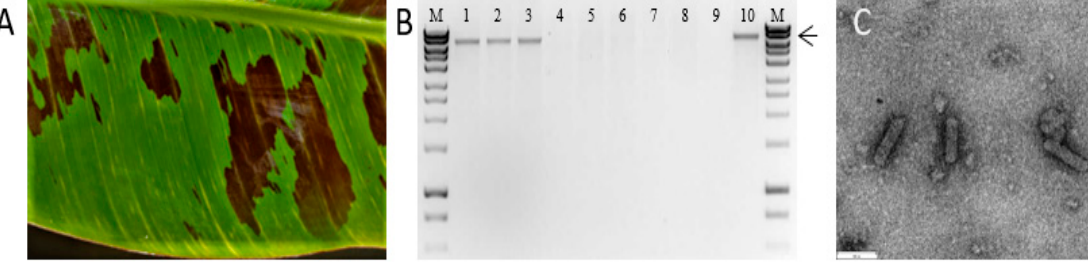
Figure 2. Inoculation of Cavendish (Williams-AAA) bananas with pOPT-EBX-BSCAV. ( A ) Typical chlorotic leaf streak symptoms of BSV infection at five weeks post-inoculation. ( B ) Rolling circle amplification analysis of TNA extracts prepared from inoculated and non-inoculated control plants at eight weeks post-inoculation. Lane M shows molecular weight (MW) marker Hyperladder 1 (Bioline, Australia), lanes 1–3 are extracts from pOPT-EBX-BSCAV inoculated plants, lanes 4–6 show plants inoculated with the binary vector pOPT-EBX only, lanes 7–8 are extracts from non-inoculated control plants, lane 9 is a no template control and lane 10 is the positive control. Arrow indicates the 8 kb MW marker fragment. The presence of a distinct ~8 kb fragment in plants inoculated with pOPT-EBX-BSCAV, but not in the control plants, is indicative of the detection of episomal viral DNA using RCA. ( C ) Transmission electron micrograph showing particles of BSCAV prepared from the leaves of banana plants six weeks post-inoculation with pOPT-EBX-BSCAV. Bar = 100 nm.